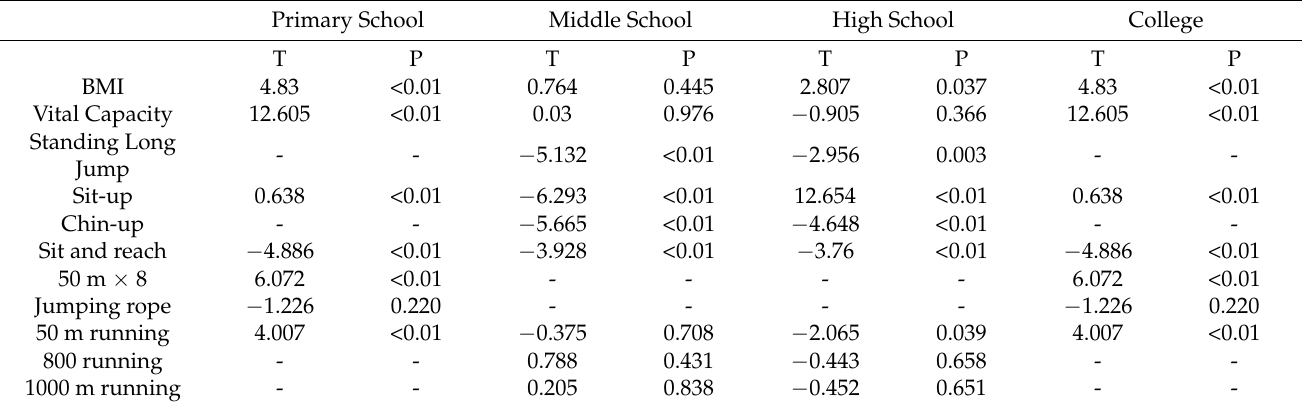
Table 5. The difference in the performance of physical fitness in region (urban = 11,132, rural =